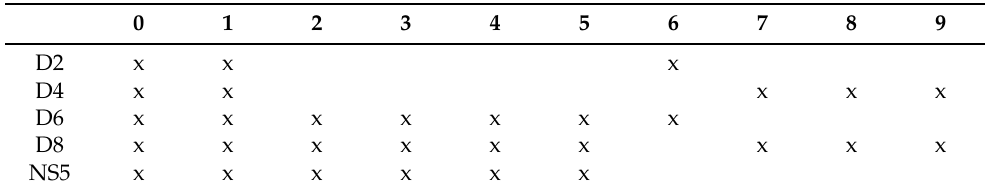
Table 1. BPS brane intersection underlying the geometry given by (1)–(3). ( x 0 , x 1 ) are the directions where the 2D CFT lives. The directions ( x 2 , . . . , x 5 ) span the CY 2 , on which the D6- and the D8- branes are wrapped. The coordinate x 6 is the direction associated with ρ . Finally, ( x 7 , x 8 , x 9 ) are the transverse directions realising the SO(3)